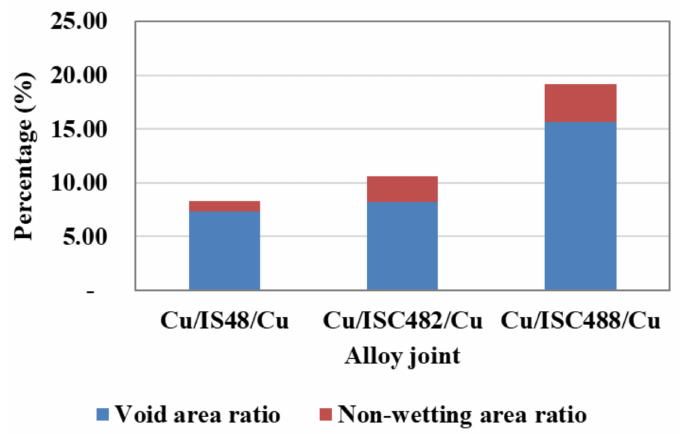
Figure 10. Percentage of void and non-wetting area on fracture surface of alloy joints.